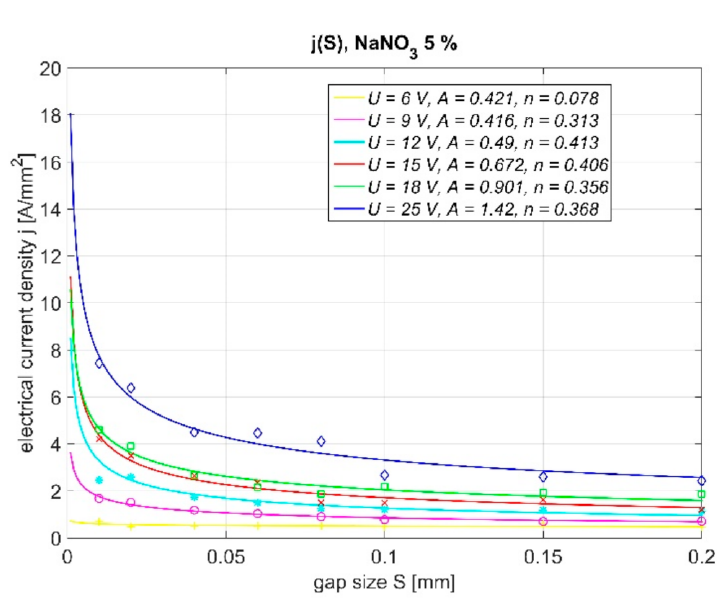
Figure 7. Set of j ( S ) characteristic for electrolyte NaNO 3